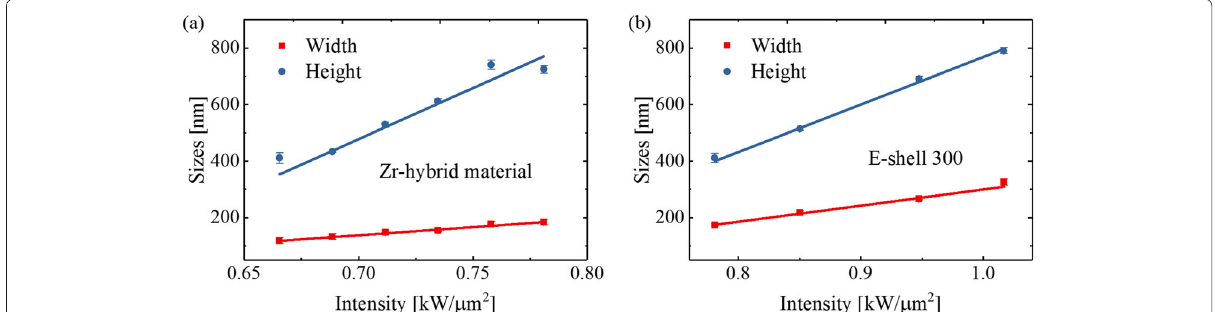
Fig. 3 Line dimensions versus the laser intensity I . The speed used for the structuring is 7 μ m/s. The red and blue lines are linear fit results of voxel width and height, respectively. a The width and height of a single line made of Zr-hybrid material. b The width and height of a single line made of E-shell